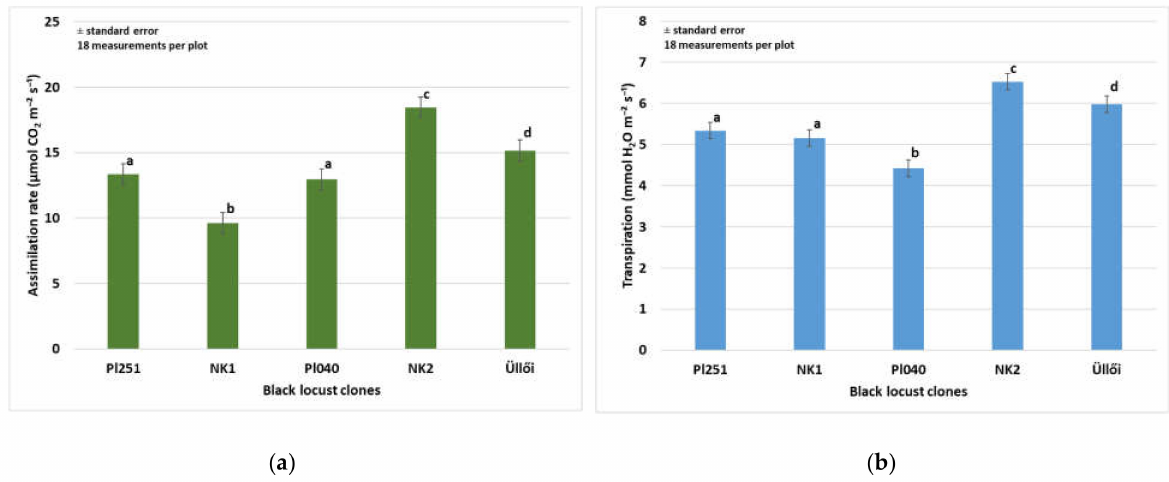
Figure 3. ( a ) Assimilation rate of black locust clones (29 May 2021) ( b ) Transpiration of black locust clones (2021); ± standard error; The different letters mean significant difference at p = 0.05 among the